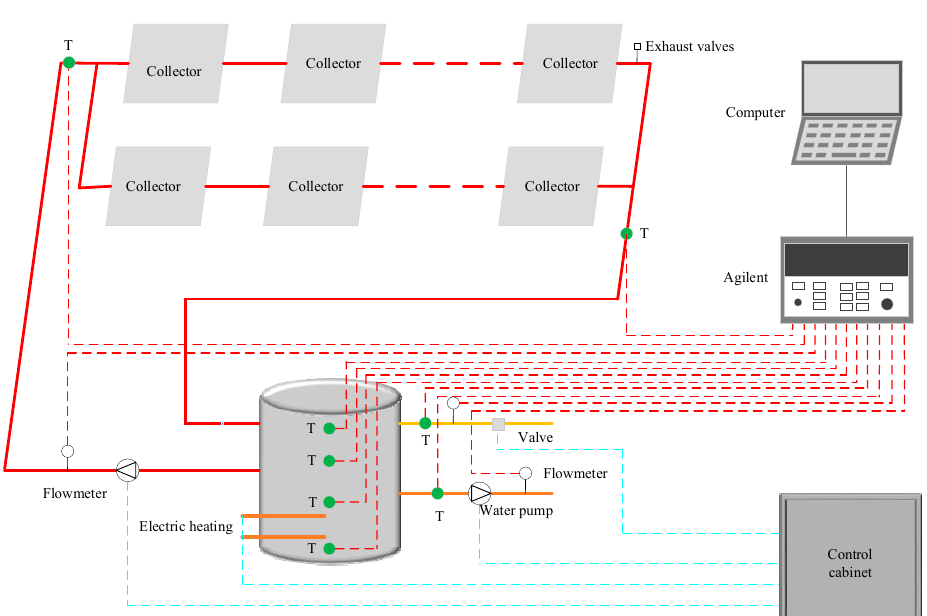
Figure 1. Diagram of the solar water-heating system.